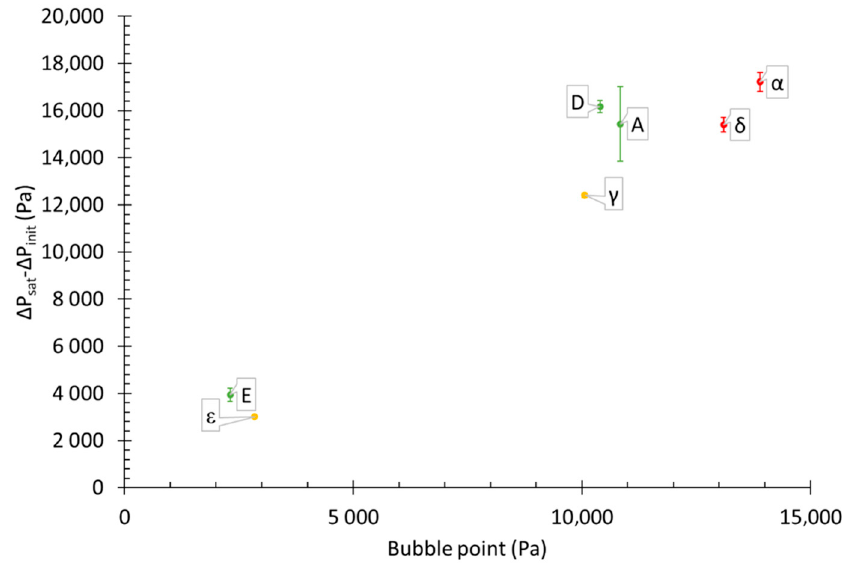
Figure 5. Pressure drop as a function of the bubble point.